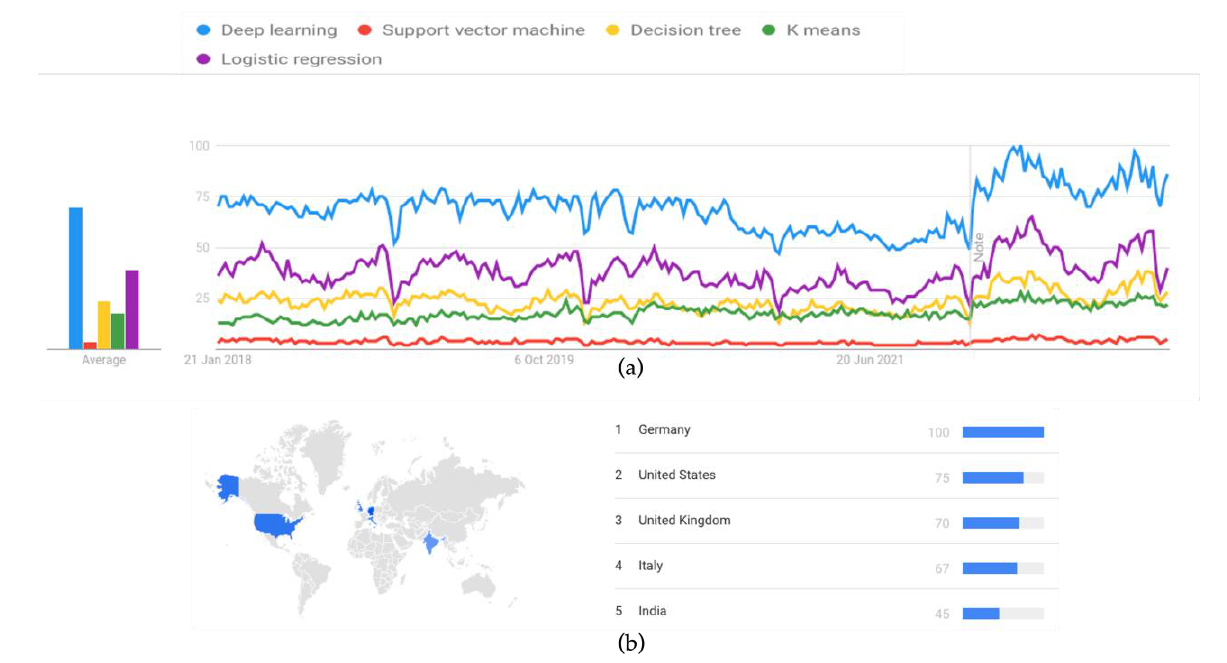
Figure 9. ( a ) Google trend on deep learning vs. some other state-of-the-art methods. ( b ) Worldwide research interest in geometric deep learning.